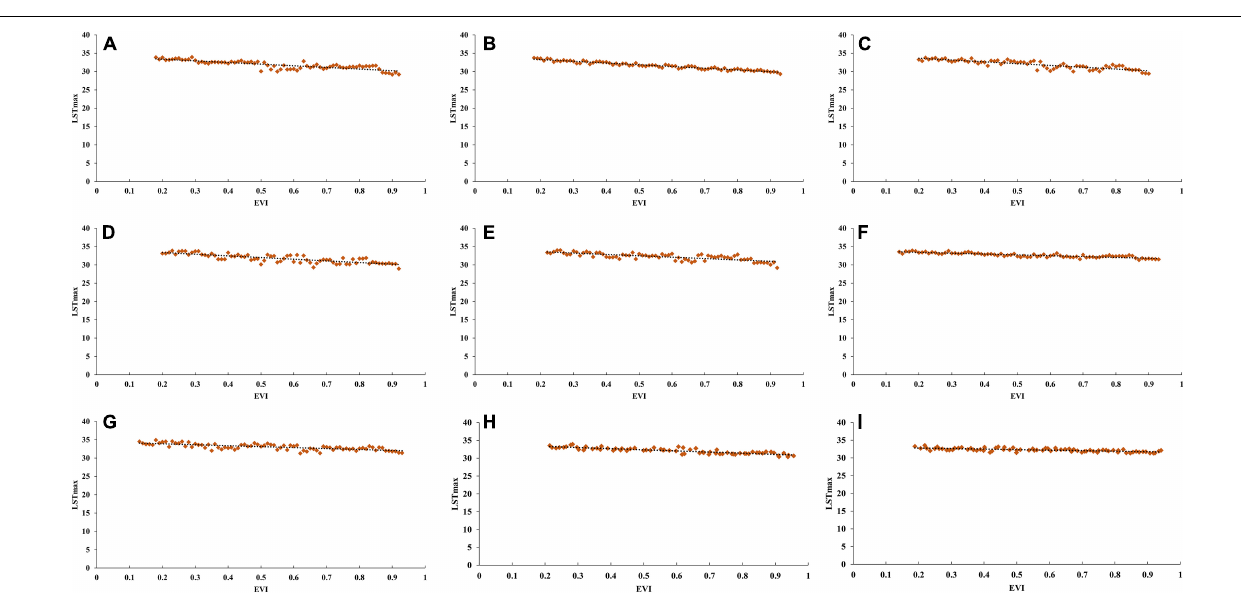
FIGURE 4 | LSTmax-EVI feature spatial fitting map of AGE for (A) 2010, (B) 2011, (C) 2012, (D) 2013, (E) 2014, (F) 2015, (G) 2016, (H) 2017, and (I)